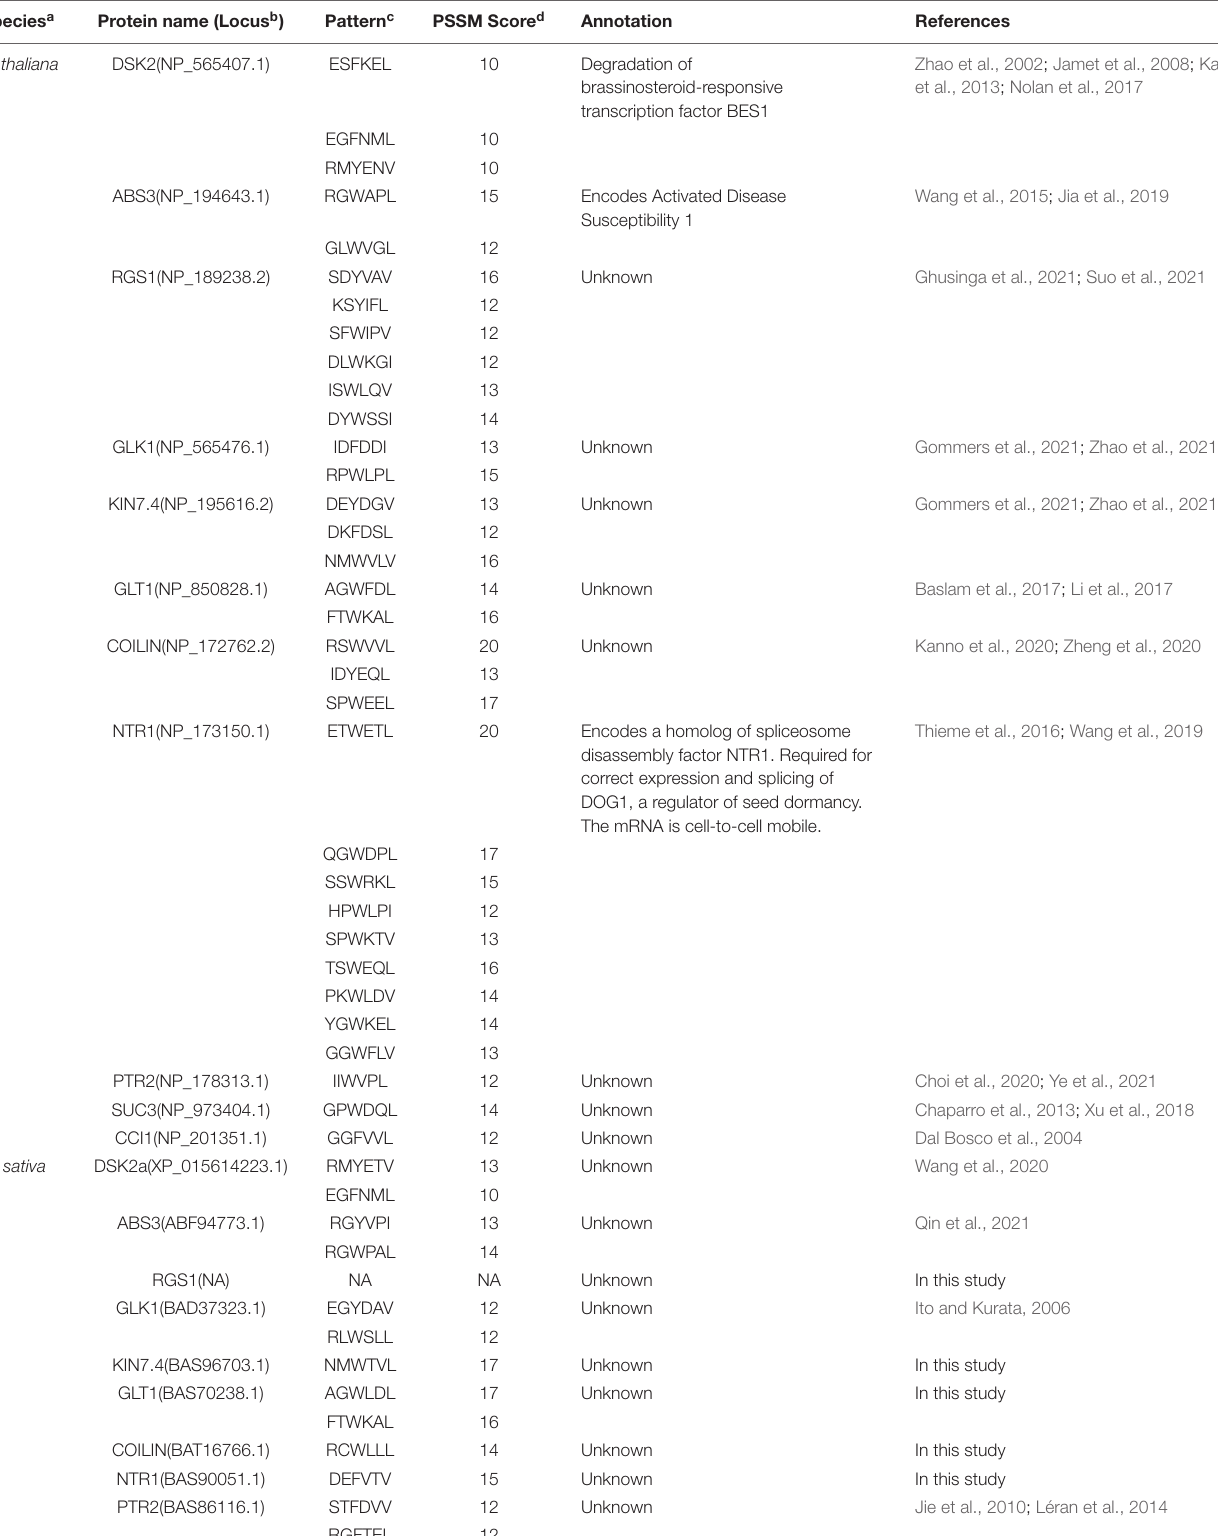
TABLE 1 | Known ATG8-interacting proteins in plant. Species a Protein name (Locus b